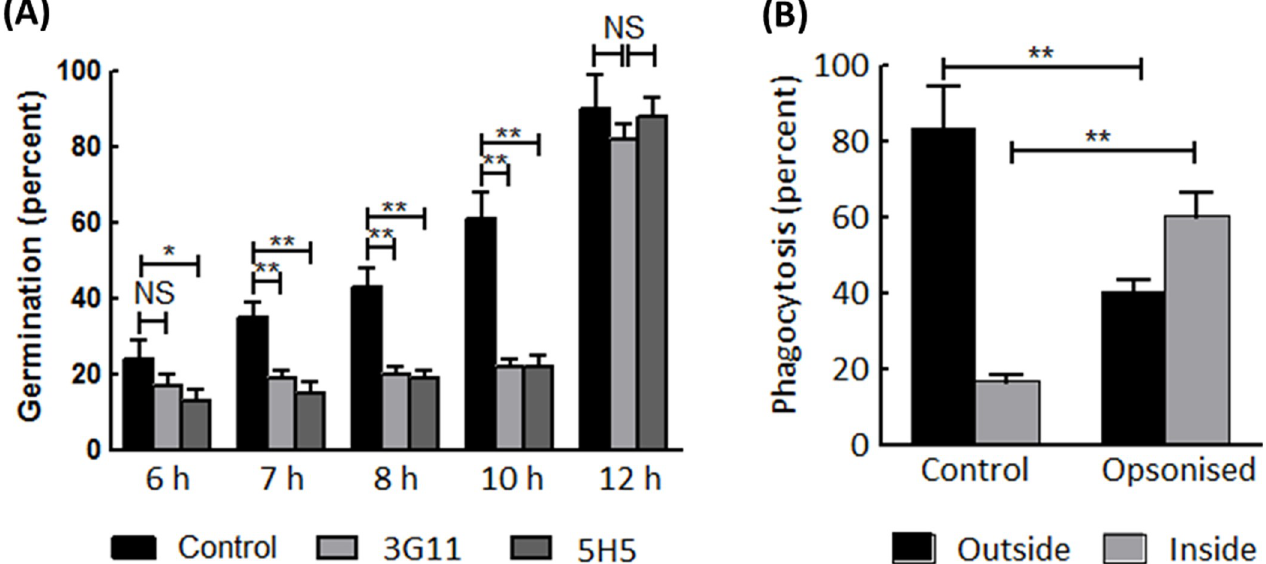
Fig 6. Antifungal activity of mAbs 3G11 and 5H5. (A) A . fumigatus germination inhibition assay. Conidia were treated with 3G11 or 5H5 (PBS buffer was used as a control) and placed on Sabouraud agar medium spread on a glass slide. Conidial germination was monitored after 6 h of incubation at 37˚C. The incubation time is shown on the X-axis. The assay was repeated three times, and at least hundred conidia were counted each time. (B) Phagocytotic assay. Swollen conidia (FITC-labelled) were treated with 3G11 for 60 min followed by feeding to human monocyte derived macrophages (HMDM). After a further 60 min of incubation at 37˚C in a CO 2 incubator, non-phagocytosed conidia were differentiated from phagocytosed FITC-labelled conidia by calcofluor white staining. Images were taken from different places to count at least one hundred swollen conidia in each experiment. Statistical analysis was performed by one- way ANOVA; � , p < 0,05 and �� , p <